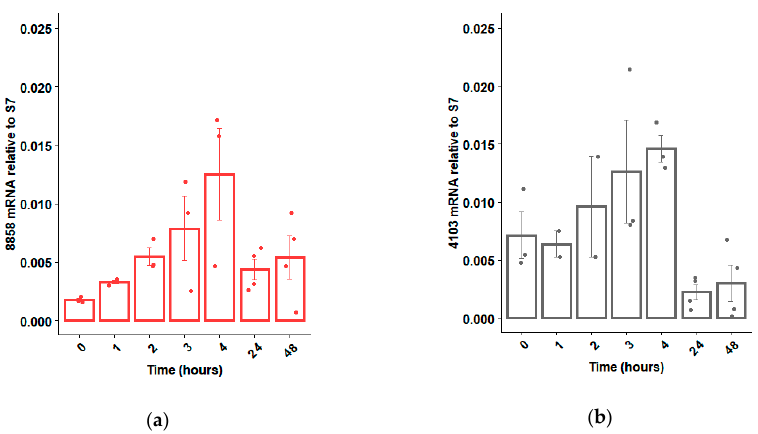
Figure 2. Expression profile of dsRNase genes 8858 ( a ) and 4103 ( b ) from pools of 10 Ae. aegypti larvae immediately post-hatch (0 h) to 48 h (early fourth instar). Expression was determined by qRT-PCR using ribosomal S7 as a control reference gene. Individual biological replicates (ranging between n = 2 and n = 4) and standard error are shown by dots and error bars, respectively.